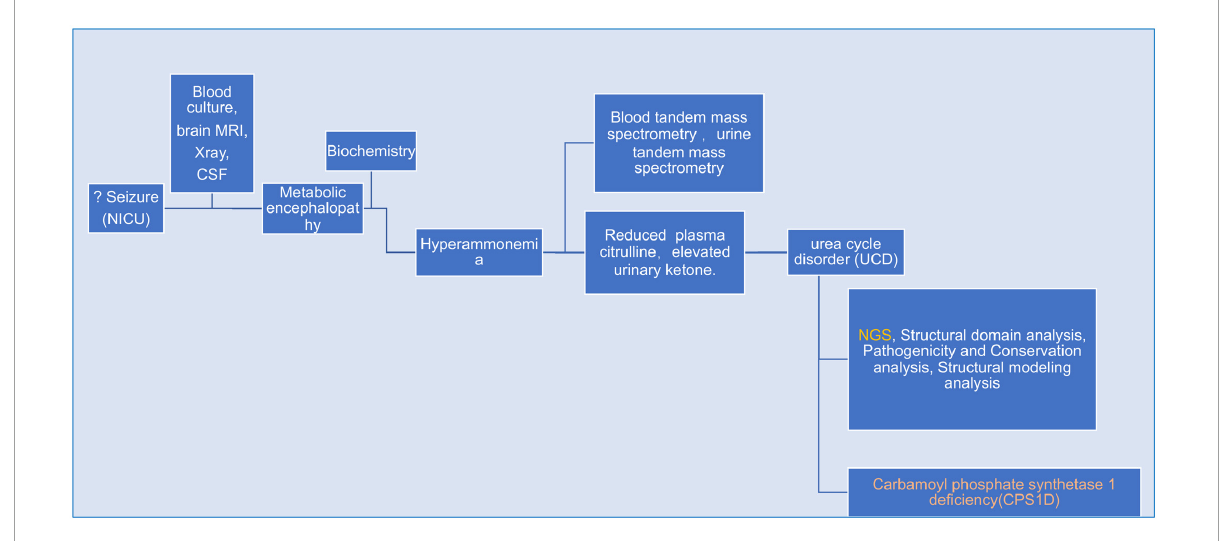
FIGURE1 A flow-chart specifically describing bioinformatics & analysis process for the whole